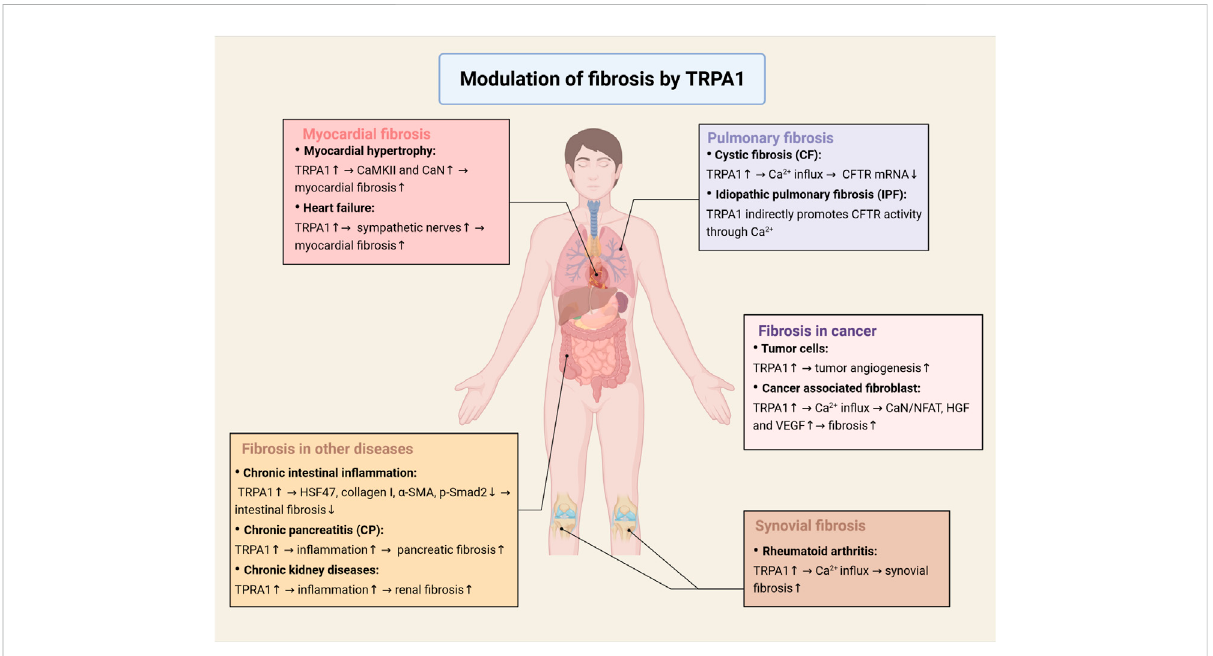
FIGURE 3 Modulation of fi brosis by TRPA1 in multiple diseases. In myocardial diseases, TRPA1 regulates the activation of the CaMKII and calcineurin signaling pathways in hypertrophic cardiomyocytes and leads to an increase in sympathetic nerves in heart failure, which promotes myocardial fi brosisand fi broblastdifferentiation.Insynovialdiseases,activationofTRPA1causescalciumin fl ux,whichpromotessynovial fi broblastproliferation. In pulmonary diseases, TRPA1 regulates the expression of CFTR protein through calcium, which is responsible for cystic fi brosis and idiopathic pulmonary fi brosis. In cancer, TRPA1 plays an important role in tumor angiogenesis, which activates neovascularization in vivo and increases cell migration and tubule formation in vitro . Calcium in fl ux induced by TRPA1 activation will activate the CaN/NFAT signaling pathway and secrete HGF and VEGF to promote cell proliferation. Apart from the diseases mentioned above, TRPA1 affects fi brosis in other diseases, such as intestinal fi brosis, pancreatic fi brosis and renal fi brosis (Created with